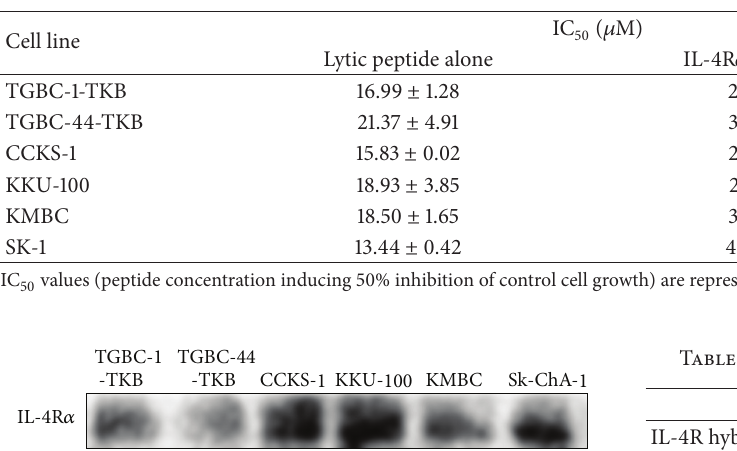
Table 1: Cytotoxic activity of IL-4R 𝛼 -lytic hybrid peptide against BTC.